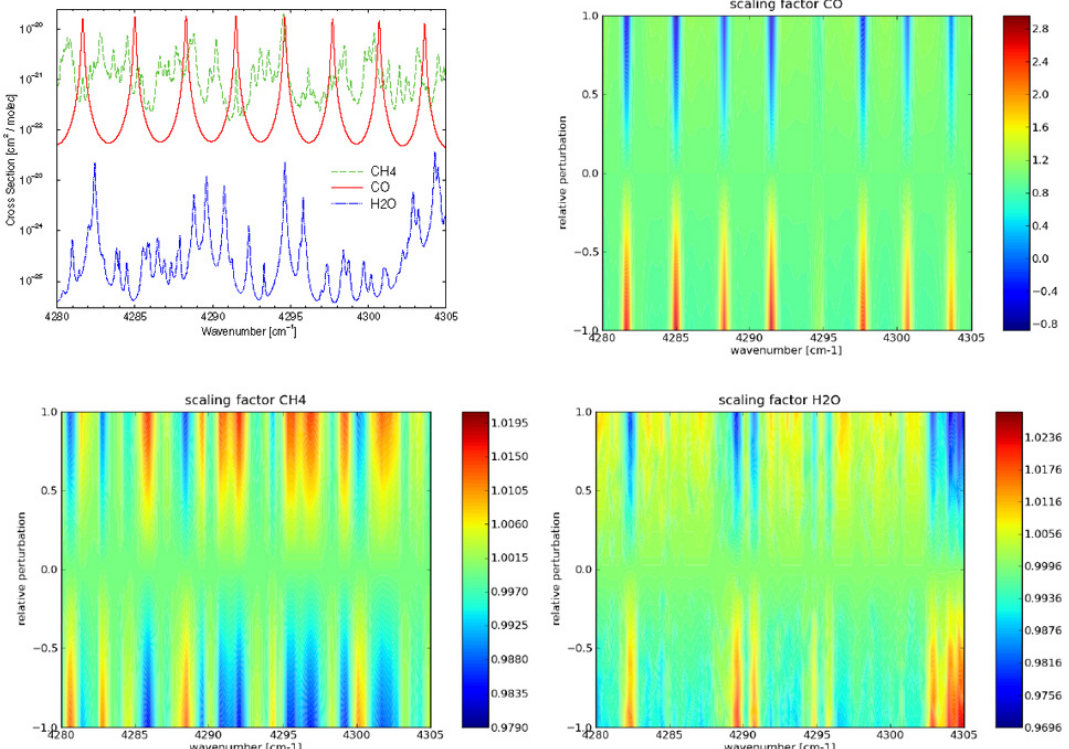
Fig. 5. Sensitivity of BIRRA CO VCDs with respect to perturbations of individual pixels. Top left: absorption cross sections of CO (red), CH 4 (green dashed), and H 2 O (blue long dashed) in channel 8 CO fitting window. Other plots: molecular scaling factors as a function of individual pixel perturbations. Note the different range of the color bars.